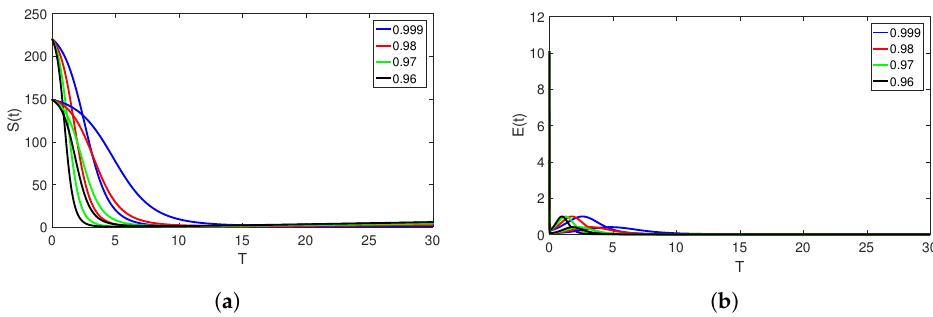
Figure 10. Dynamical behavior of the susceptible class ( a ) and exposed class ( b ) on different arbitrary fractional order ς on sub interval [ 0, t 1 ] and [ t 1 , T ] of [ 0, T ] , for different initial values.